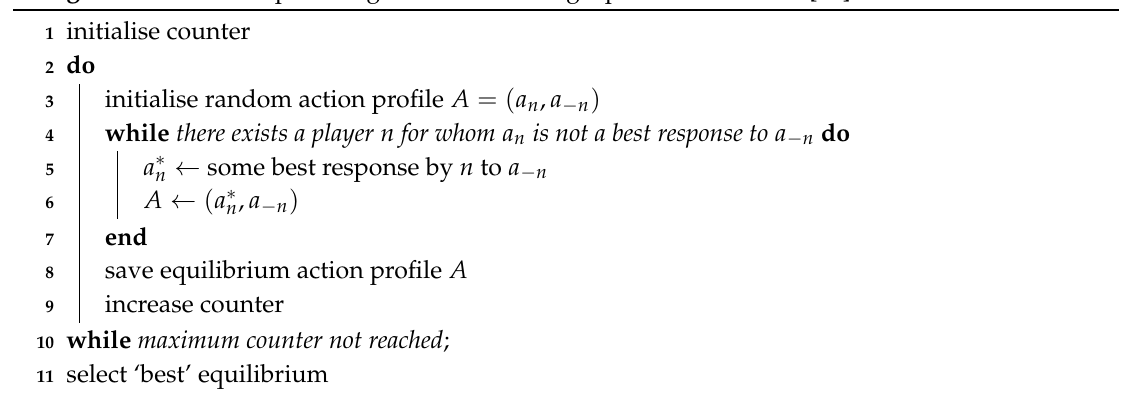
Algorithm 1: Best-response algorithm for finding a pure NE based on